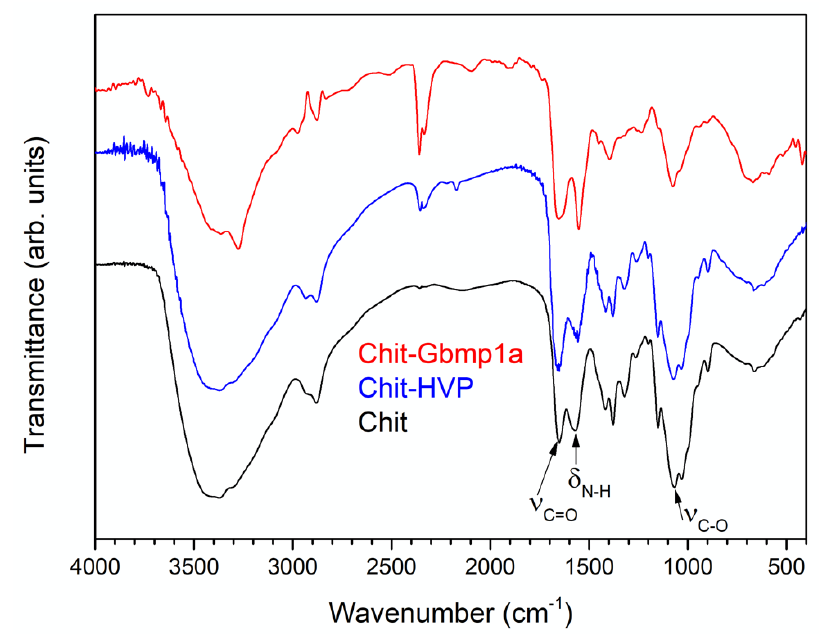
Figure 1. FT-IR spectra of Chit (black), Chit-HVP (blue), and Chit-GBMP1a (red). The main features in the chitosan spectrum (black line) are the broad band located at 3550 cm − 1 and related to O-H stretching vibrations and the peak located at 1080 cm − 1 due to C-O stretching vibrations and labelled ν C-O in Figure 1. Since the hydrolysis of the amide functions present in the chitin molecules is seldom complete, peaks related to C=O stretching and N-H bending vibrations of residual amides are evident in the spectrum, located at 1650 cm − 1 ( ν C=O ) and 1560 cm − 1 (labelled δ N-H ), respectively [62]. The spectra of the two peptide-functionalized samples, Chit-HVP (blue) and Chit- GBMP1a (red), are very similar to the spectrum of pristine chitosan, with the same peaks in the same position. However, the intensity ratio between the amide-related peaks (at 1650 and 1560 cm − 1 ) and the C-O stretching peak of chitosan (at 1080 cm − 1 ) is higher in the peptide-functionalized samples compared to pristine chitosan. This effect is proof of the successful peptide immobilization, since peptide bonds also contribute to the amide bands at 1650 and 1560 cm − 1